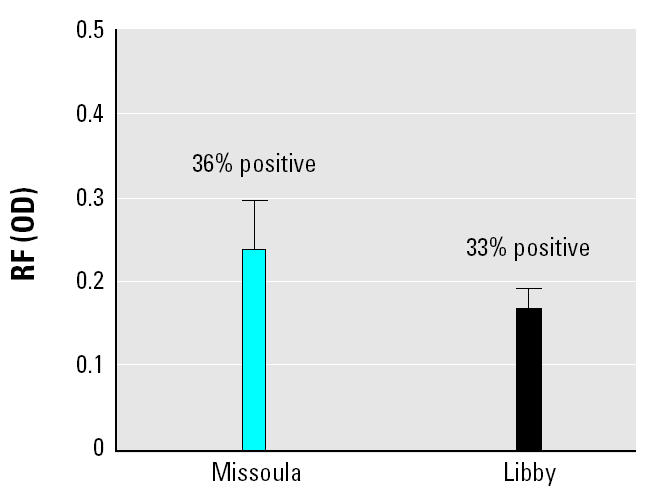
Evaluation for IgM RF by ELISA. Neither the percent positive (based on kit positive and negative controls) nor the mean OD calculated for each group was statistically significant (Fisher’s exact test and t-test, respectively).